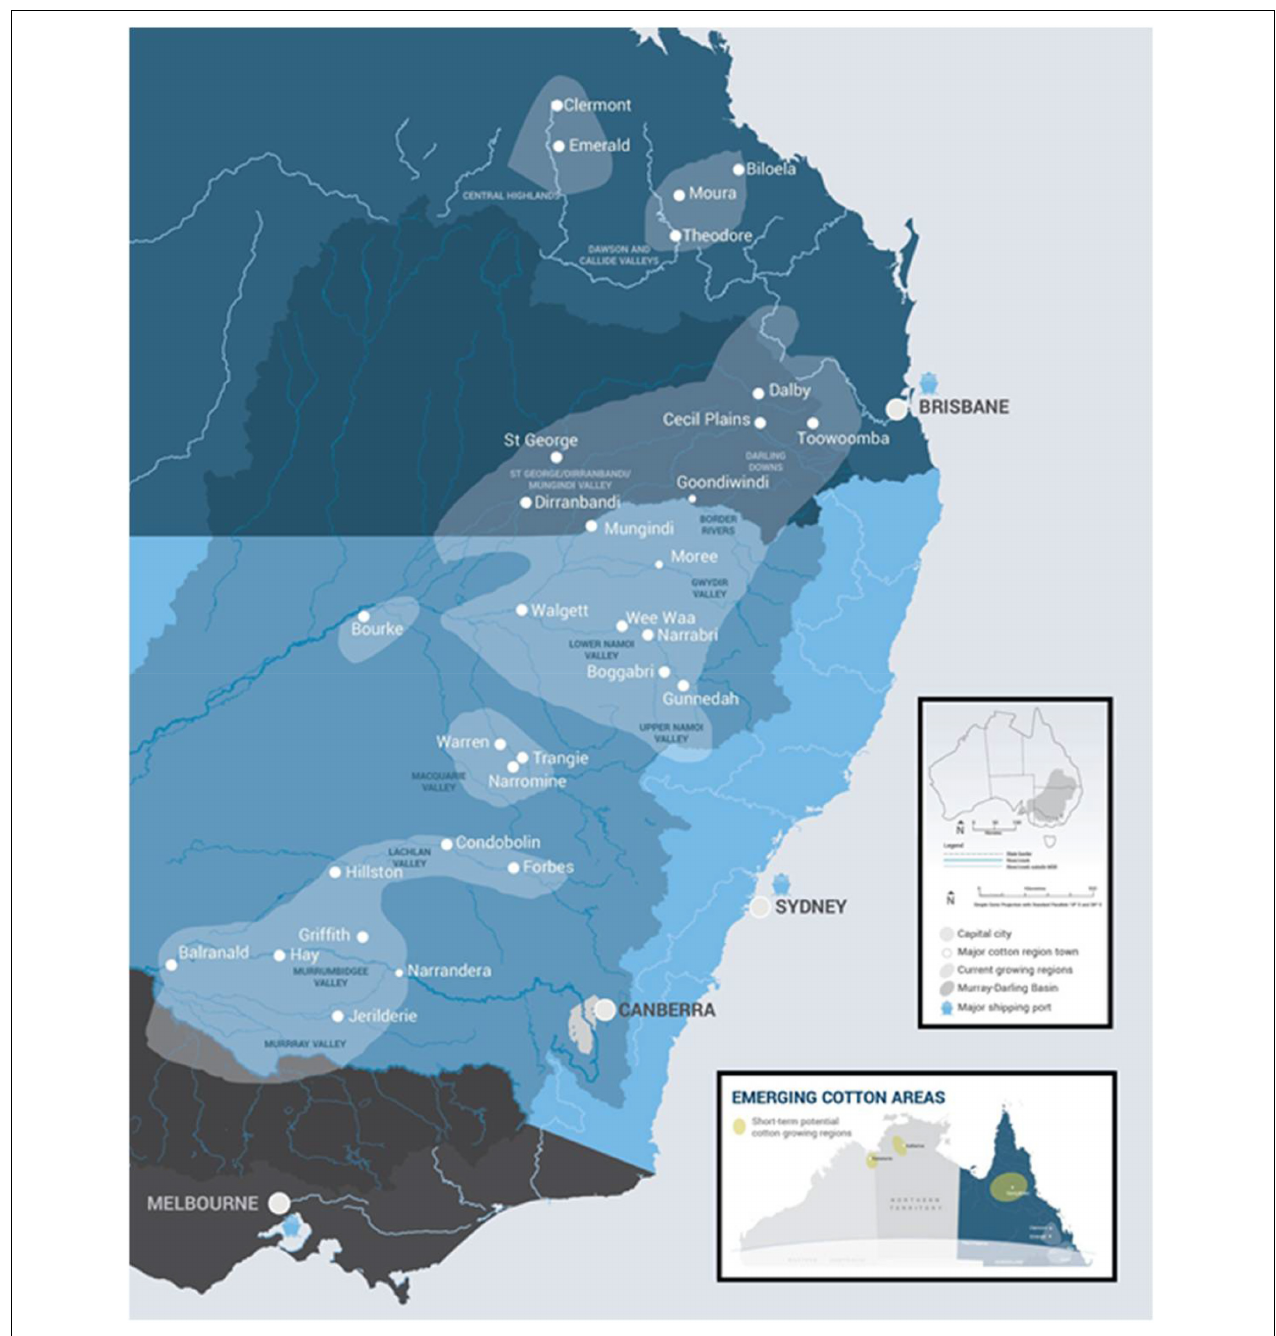
FIGURE 1 | The Australian cotton growing regions extend from latitudes of –36 ◦ (Murray Valley) to –22 ◦ (Central Queensland). Source: Cotton Australia